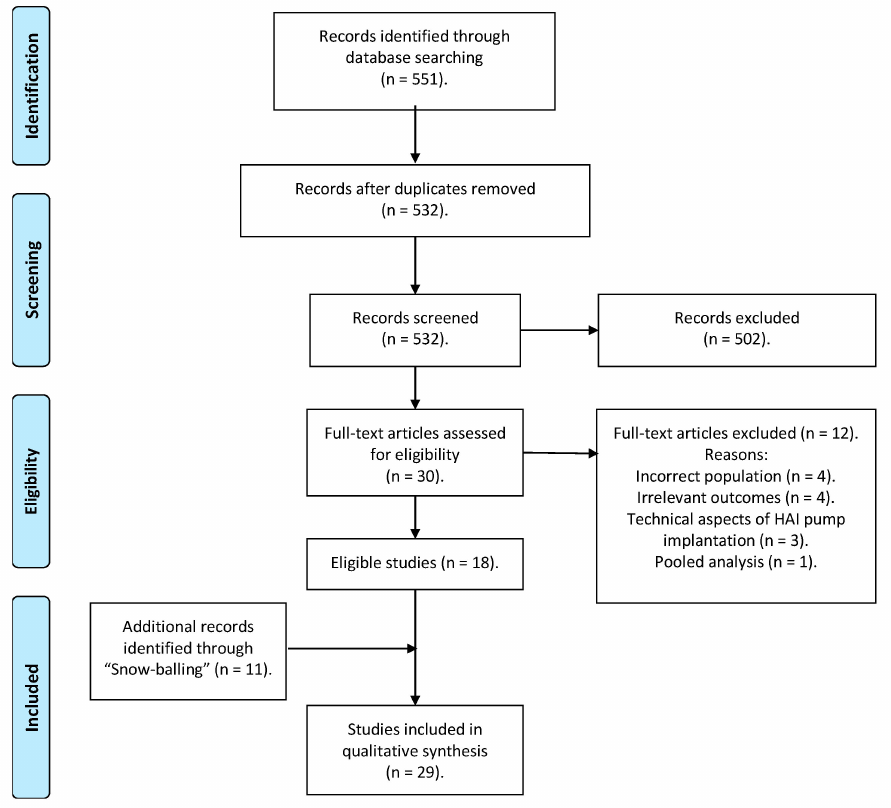
Figure 1. PRISMA flow